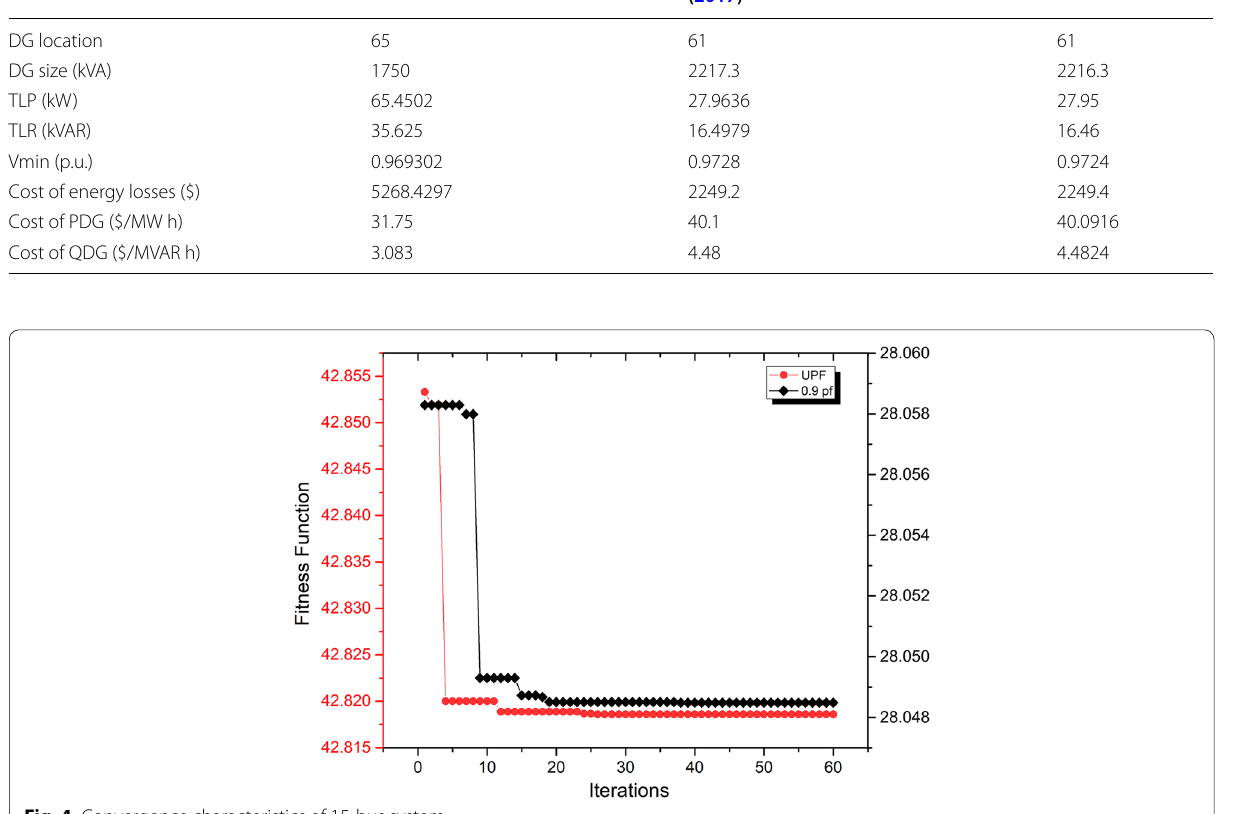
Fig. 4 Convergence characteristics of 15-bus system